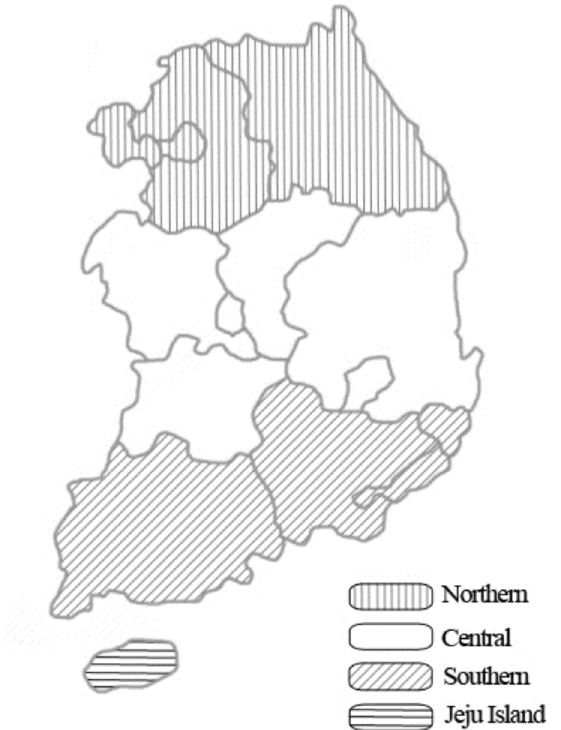
Fig 1. A map of South Korea showing the four different study regions where blood samples were collected from horses to detect Coxiella species.